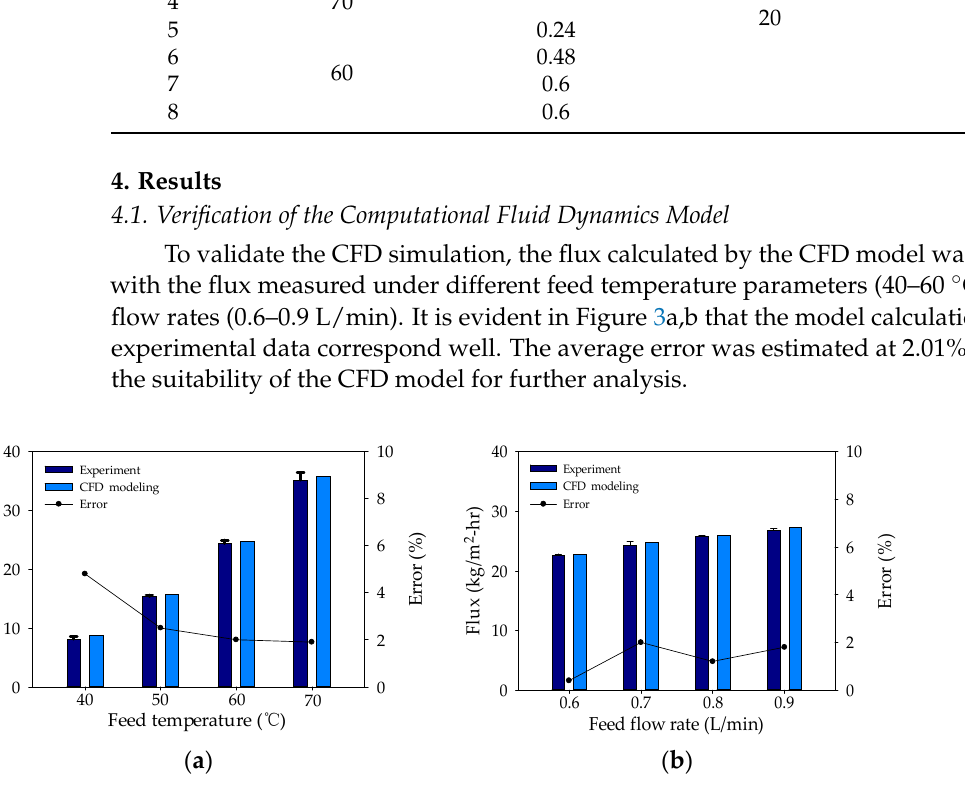
Figure 3. Validation of CFD model, experimental water flux results, and error rate: ( a ) difference in feed temperatures and ( b ) difference in feed flow rates.